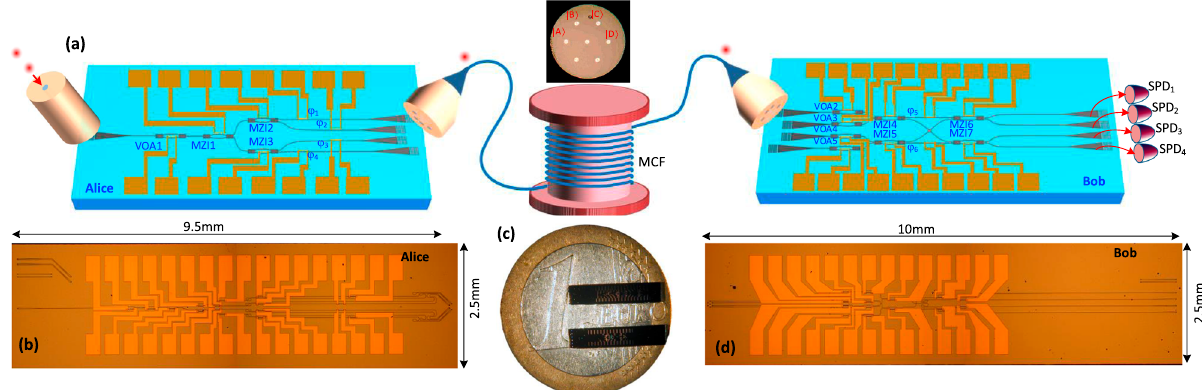
Fig. 1 a Schematic of the HD-QKD based on MCF using silicon PIC for Alice and Bob. The inset shows the cross-section of the multi-core fi ber, where four cores are used. b , d Shows the fabricated silicon PIC for Alice and Bob, respectively. c Presents the picture of the fabricated chips with a 1 euro coin, indicating the compact size of the silicon